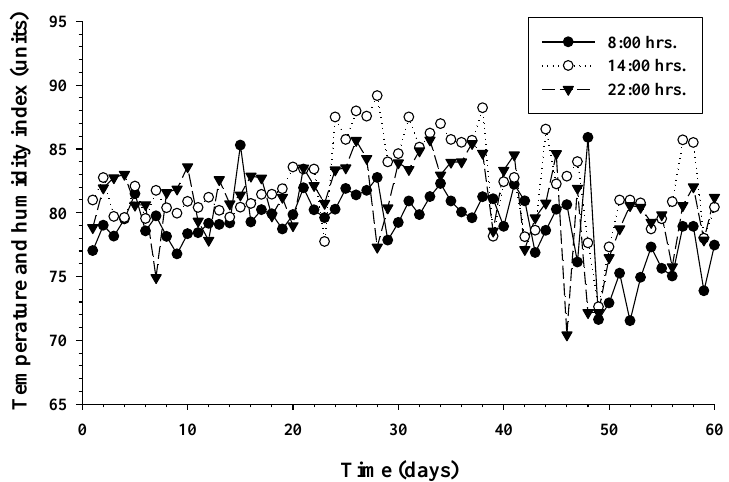
Figure 1. Daily changes of the temperature and humidity indexes (THI) at different hours during summer months in South China